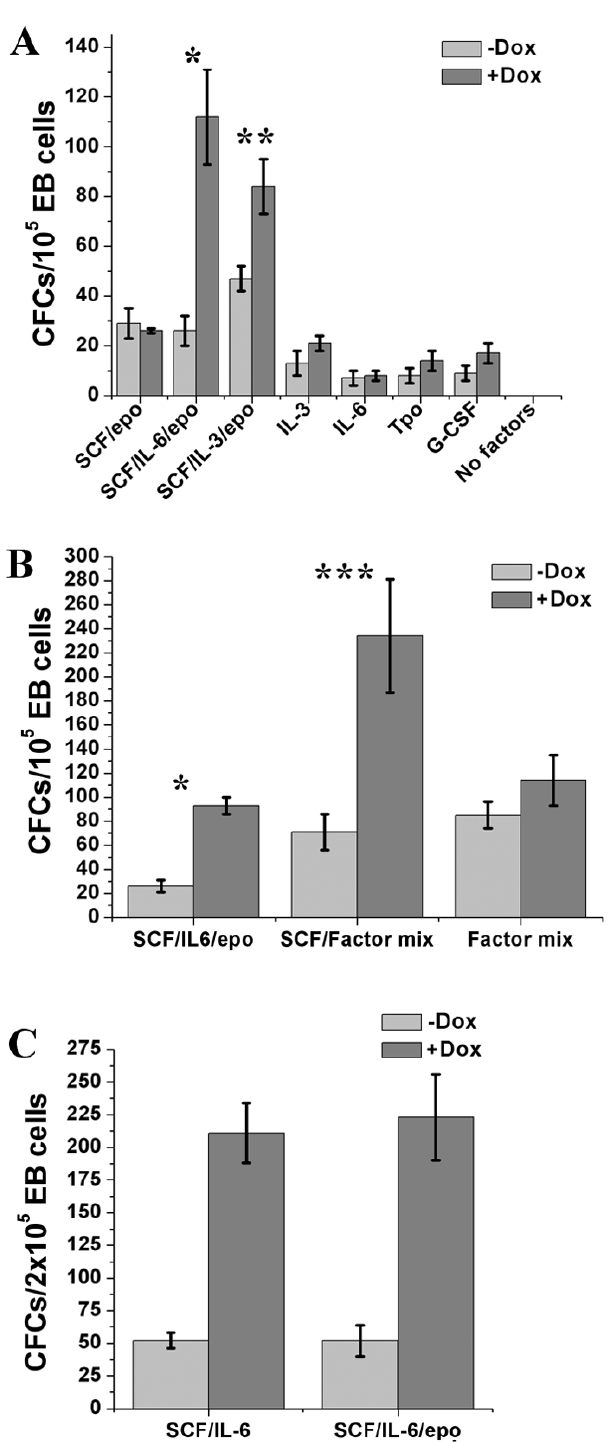
Figure 3. The synergistic effect of Lhx2 expression on colony formation is growth factor-specific. A. Frequency of definitive CFCs inday6EBcellsgeneratedfromiLhx2EScellsrespondingtotheindicated growth factors/growth factor combinations in clonal assays performed in the absence ( 2 Dox) or presence ( + Dox) of dox. B. Frequency of definitive hematopoietic progenitor cells in day 6 EB cells responding to the indicated growth factor combinations in clonal assays in the absence ( 2 Dox)orpresence( + Dox)ofdox.FactormixisTpo,IL-3,IL-6,Flt3L,epo. C. Number of definitive hematopoietic progenitor cells responding to the indicated growth factor combinations in the absence ( 2 Dox) or presence ( + Dox) of dox. * p , 0,002, ** p , 0,01, *** p , 0,005.